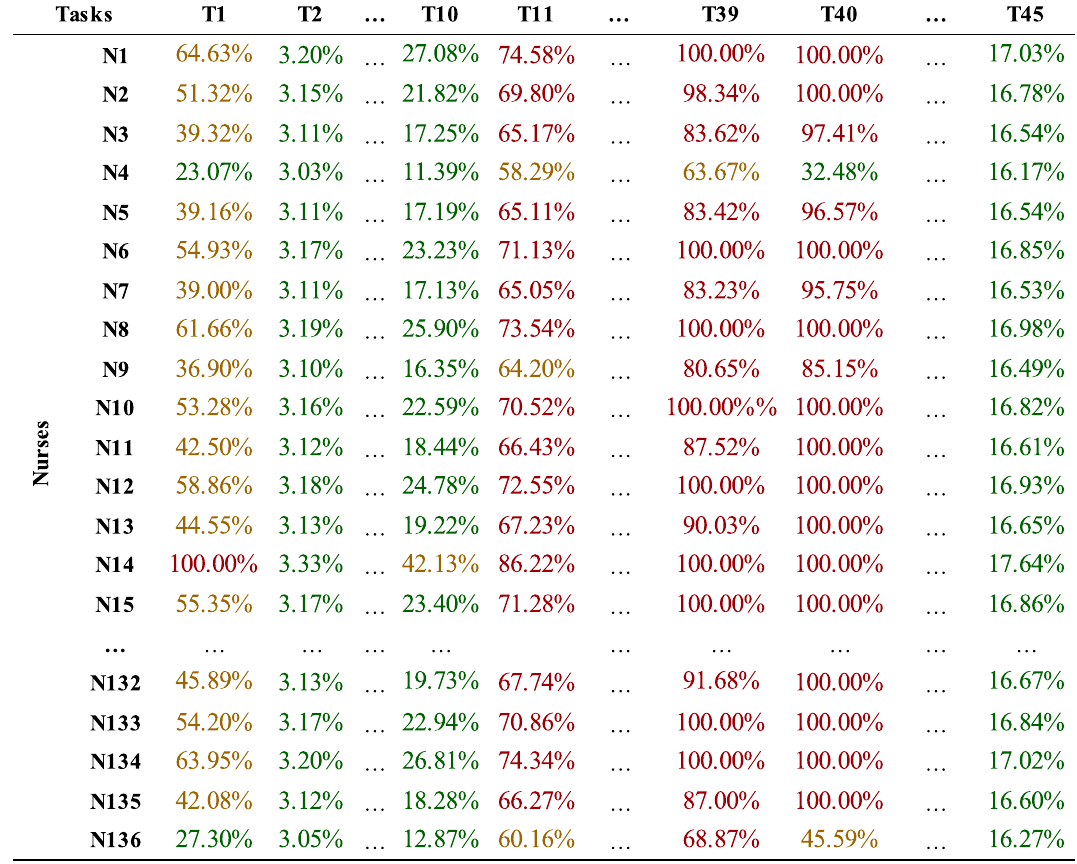
values for nurses t